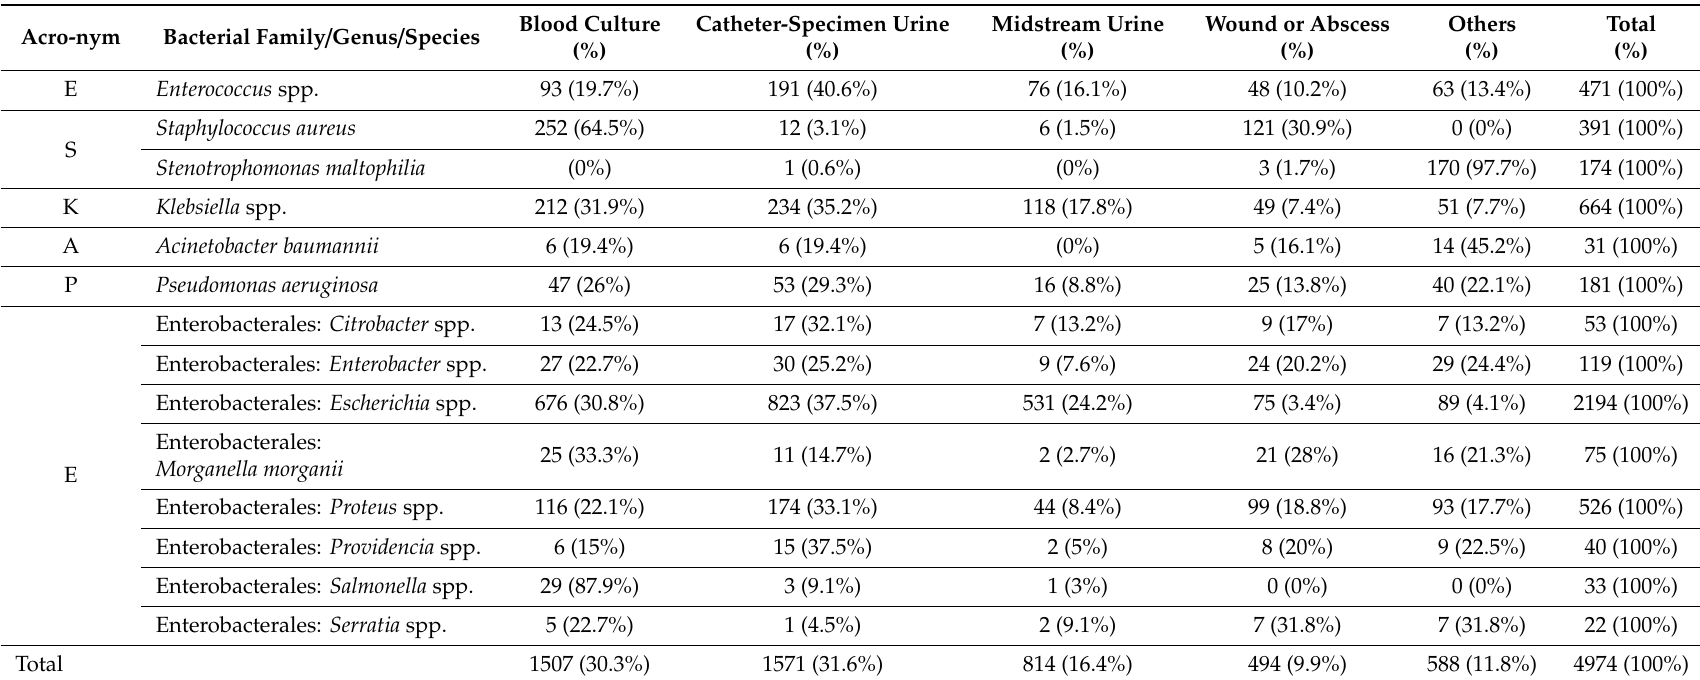
Table 2. Distribution of ESKAPE isolates by clinical